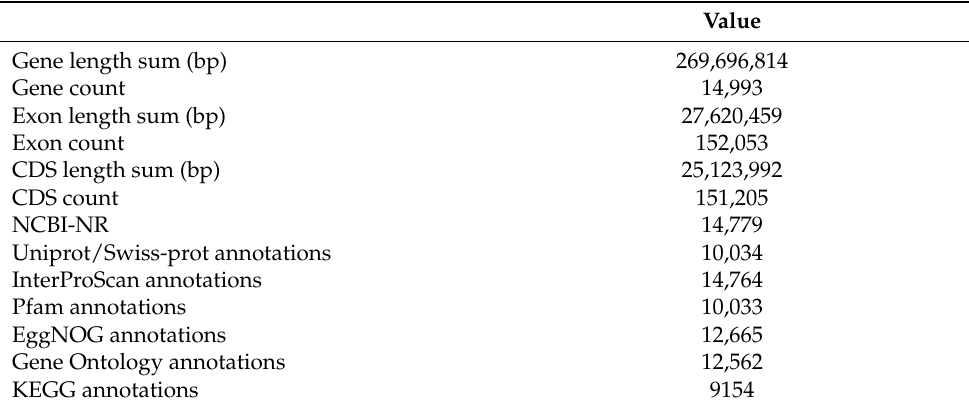
Table 3. Summary of the Macronectes giganteus gene annotations.